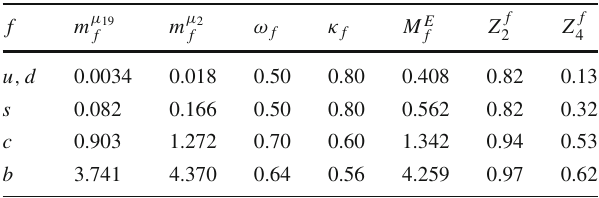
μ 19 = m ( 19GeV ) , m μ 2 = f f f f